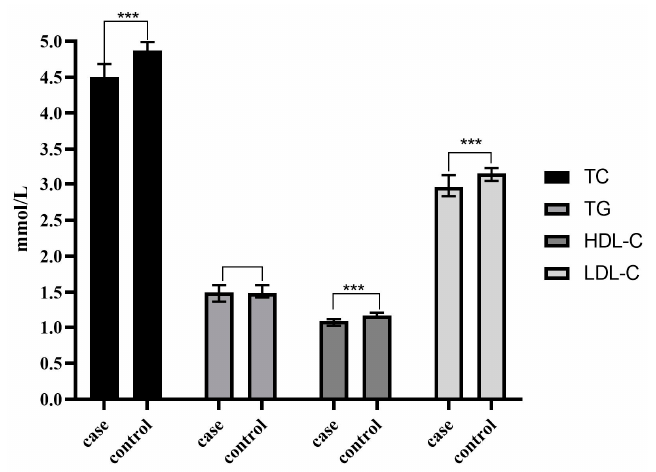
Figure 2. Serum lipid difference between case and control groups in our study. TC: Total cholesterol; TG: Triglycerides; HDL-C: High-density lipoprotein cholesterol; LDL-C: Low-density lipoprotein cholesterol; CA19-9: Carbohydrate antigen 19-9; *** p < 0.001. Table 2. Univariate analysis of risk factors for Univariate analysis of potential PC risk variables found that BMI ( p < 0.001), smoking